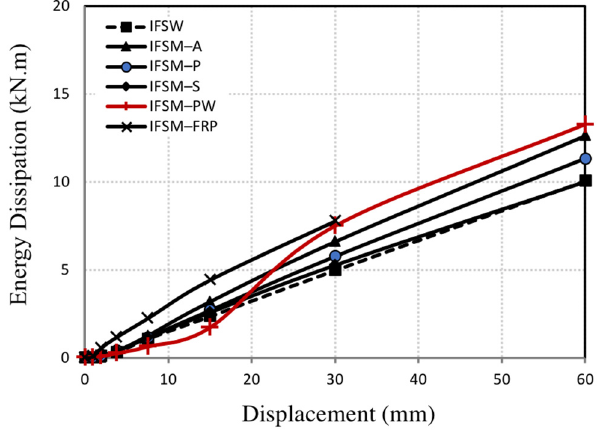
Figure 11. Cumulative energy dissipation of specimens.